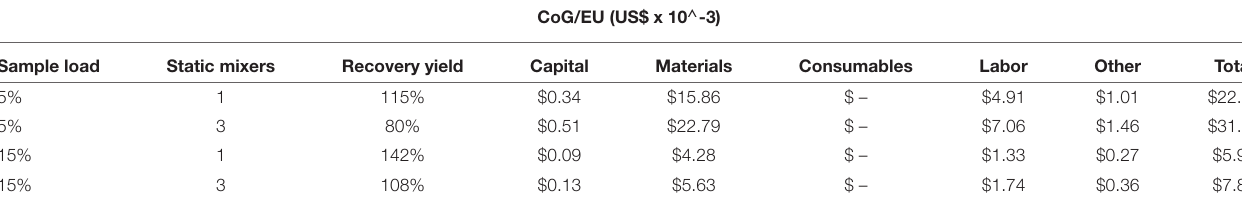
TABLE 4 | Results for the economic analysis. Breakdown and totals for cost of Goods per Enzymatic